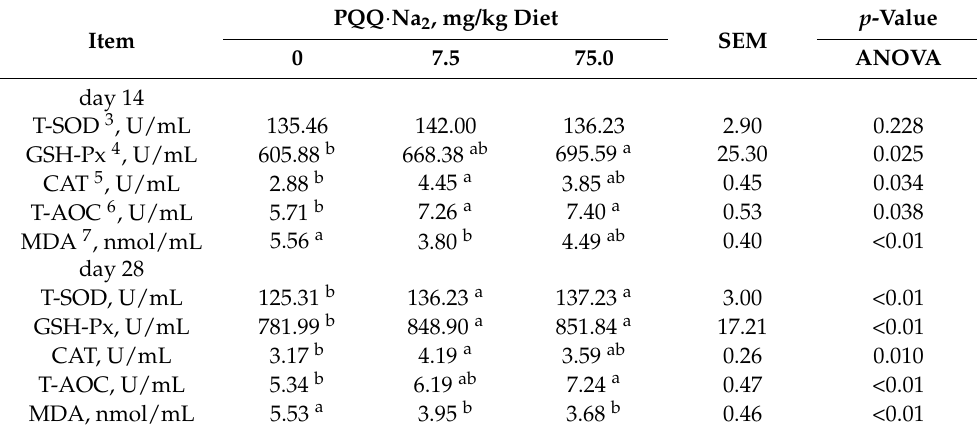
Table 7. Antioxidant indexes in serum of weaned pigs fed graded levels of PQQ · Na 2 1 for 28 d 2 .